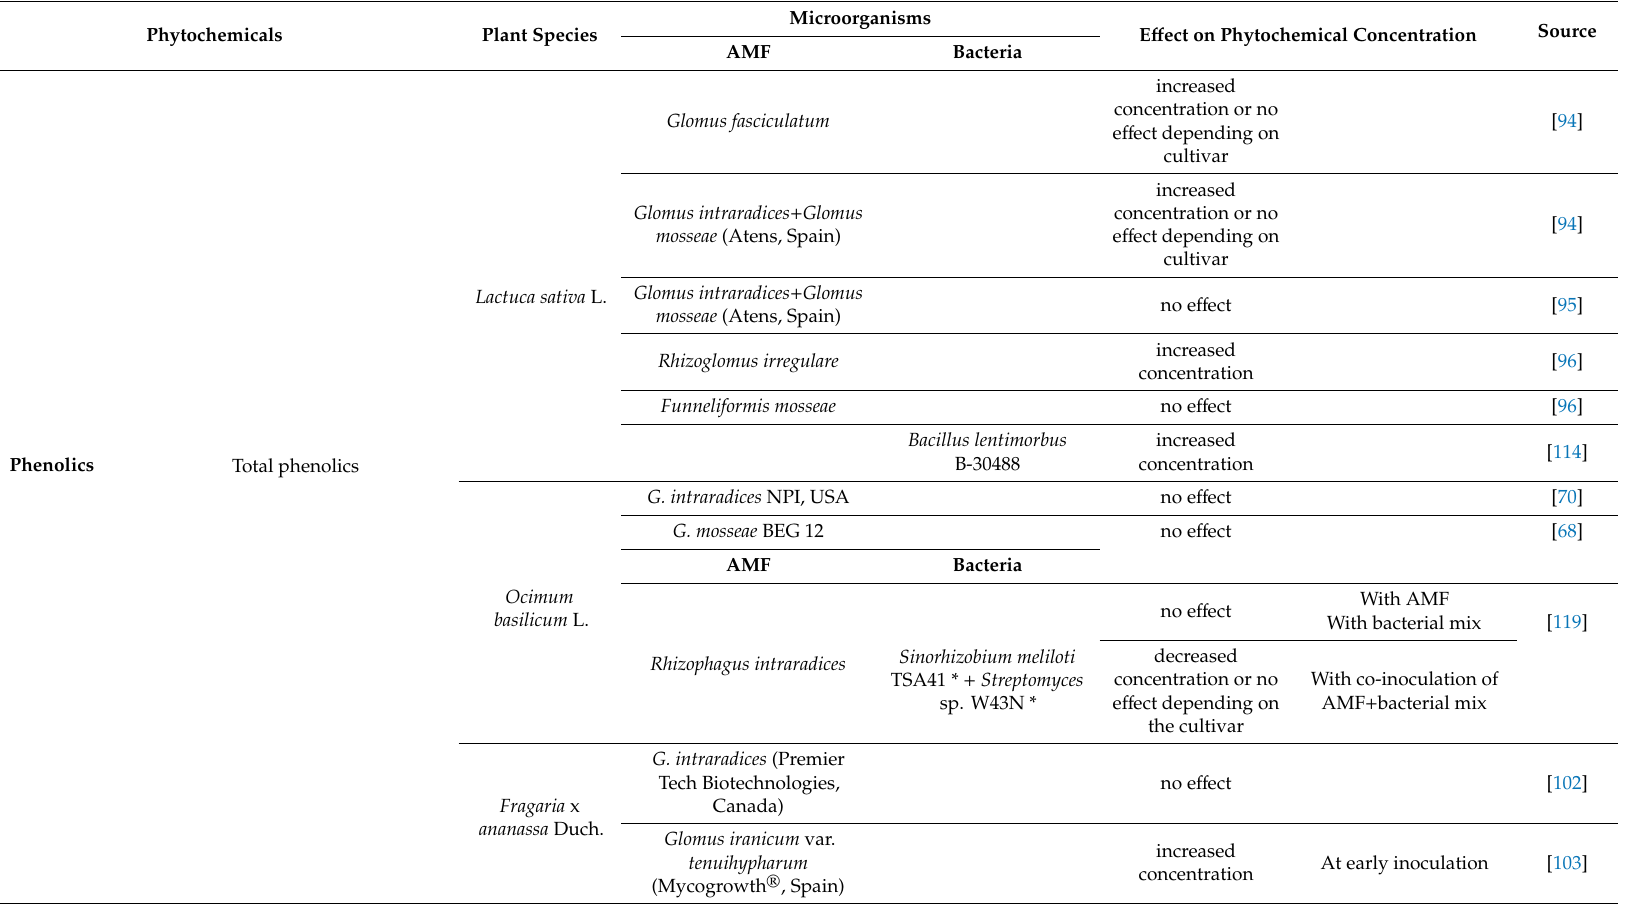
Table 1. Secondary metabolites as a ff ected by inoculation of arbuscular mycorrhizal fungi (AMF), plant growth-promoting bacteria, and AMF-associated bacteria (*) in selected food